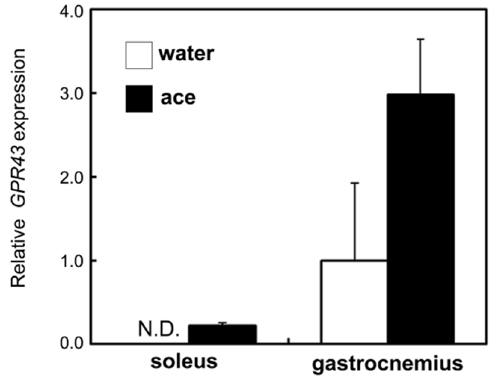
Figure 7. Long-term supplementation with acetic acid tends to induce the expression of G protein- coupled receptor 43 (GPR43) gene in the soleus muscle of SD rats at 56 weeks of age. Values repre- sent means ± SE for 4 – 5 rats. N.D.: not detected.